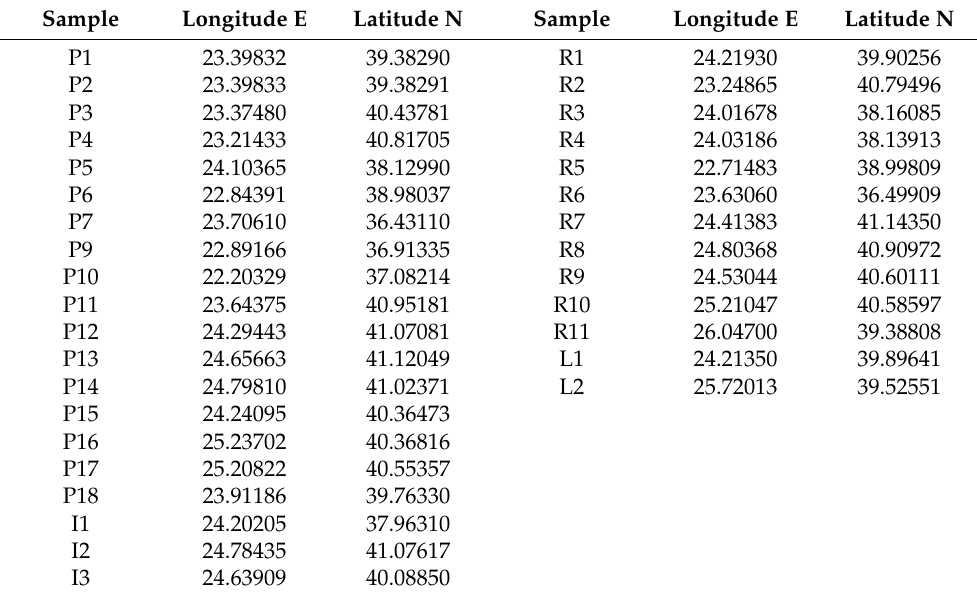
Table 1. Geographical coordinates of sampling sites—Global Positioning System (GPS).